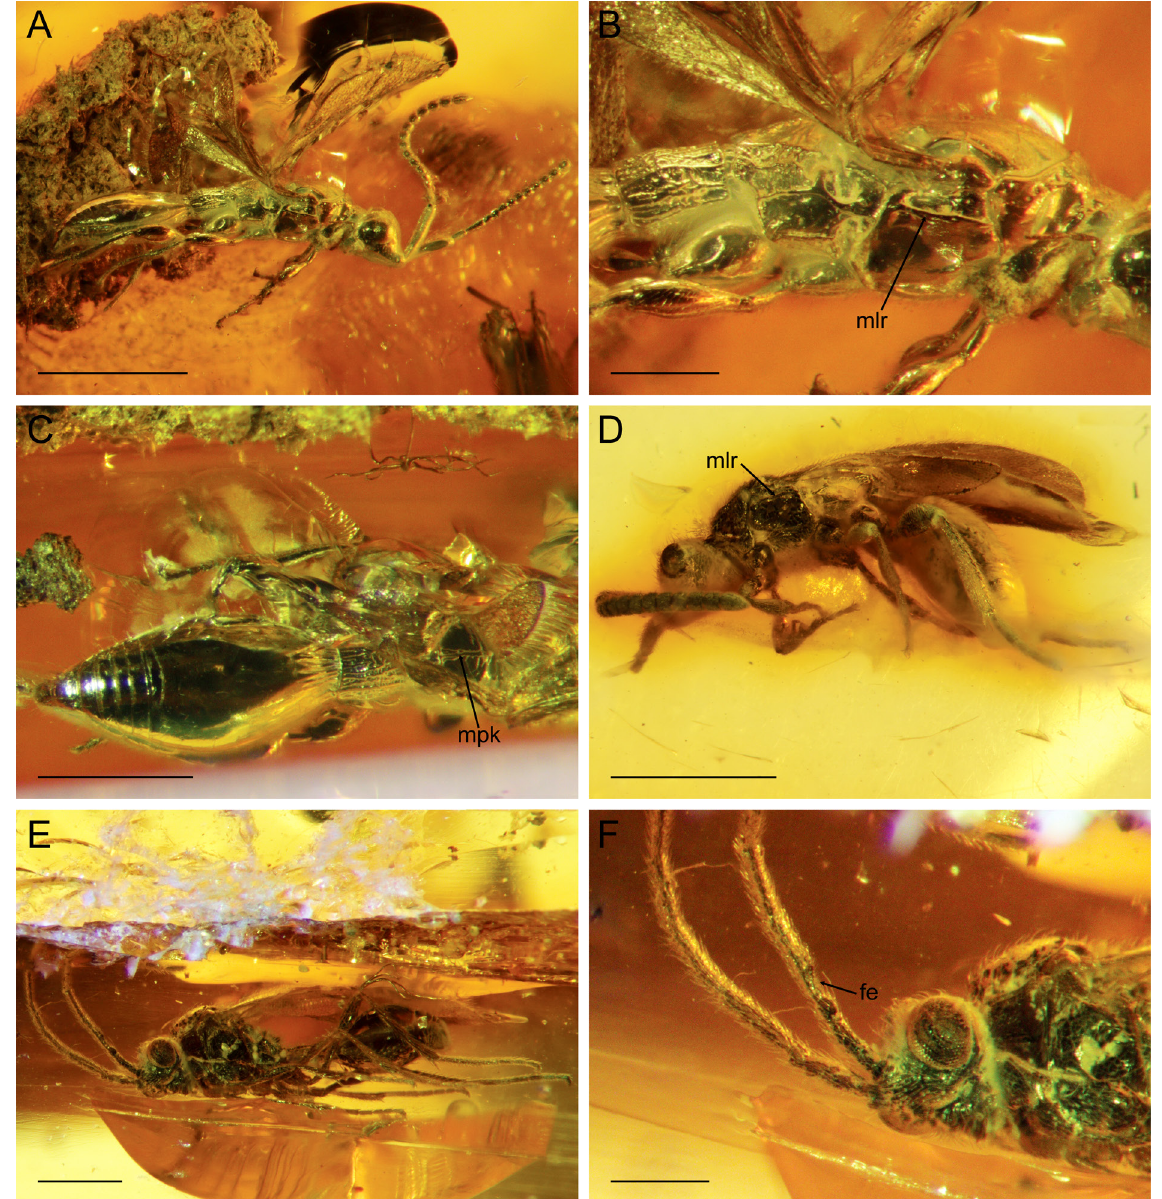
Fig. 2. A–D . Belyta knudhoejgaardi sp. nov. A–C . Holotype (NHMD-608408). A . habitus in lateral view. B . Mesosoma and petiole in lateral view. C . Petiole and gaster in dorsal view. D . Paratype NHMD-608400, habitus in lateral view. E–F . Cinetus breviscapus sp. nov., holotype (NHMD-300622). E . Habitus in lateral view. F . Head in lateral view. Abbreviations: fe = flagellomere emargination; mlr = mesopleural longitudinal ridge; mpk = median propodeal keel. Scale bars: A = 2 mm; B, F = 0.5 mm; C–E = 1